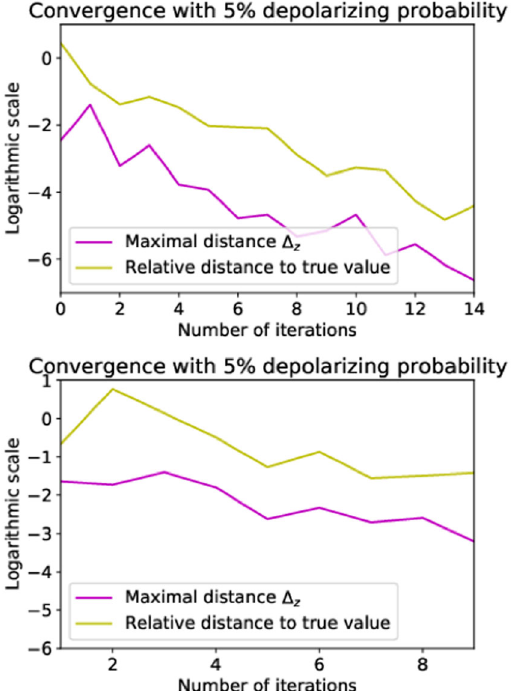
Fig. 3 Convergence check. Illustration of convergence check for MPS in a rapid and slow mixing scenario. We consider a bath of 9 qubits arranged on a line. In each iteration a new system qubit is added and a fi xed circuit is run between the bath and the new system qubit. In the rapid mixing case, we perform a depth 3 circuit between the system qubit and the bath such that each gate is followed by a depolarizing channel with probability 5%. The complete state was evolved for 50 time steps and, thus, consists of total of 50 qubits, and we measured Pauli observables on the last two qubits. In the slow mixing we perform a depth 2 circuit instead. If we denote by X t the expectation value of the state evolved by t steps, we de fi ne the relative error to the true value to be ∣ 1 − X t / X 50 ∣ , as X 50 corresponds to preparing the whole state. To generate each plot, we have generated 50 instances where the gates in the circuits were picked at random for each instance. The fi gures display the logarithm in base 10 of the average of the quantities. Even with moderate levels of noise, we can faithfully reproduce the expecta- tion value up to a relative error of 10 − 2 after 5 iterations, giving an order of magnitude saving in the number of qubits in the rapid mixing scenario, while in the slow mixing, we required around 13. Moreover, we have picked 20 random initial states to estimate Δ z , as more initial states did not seem to improve the estimate. As we can see, Δ z is a good proxy for the relative distance to the true expectation value.